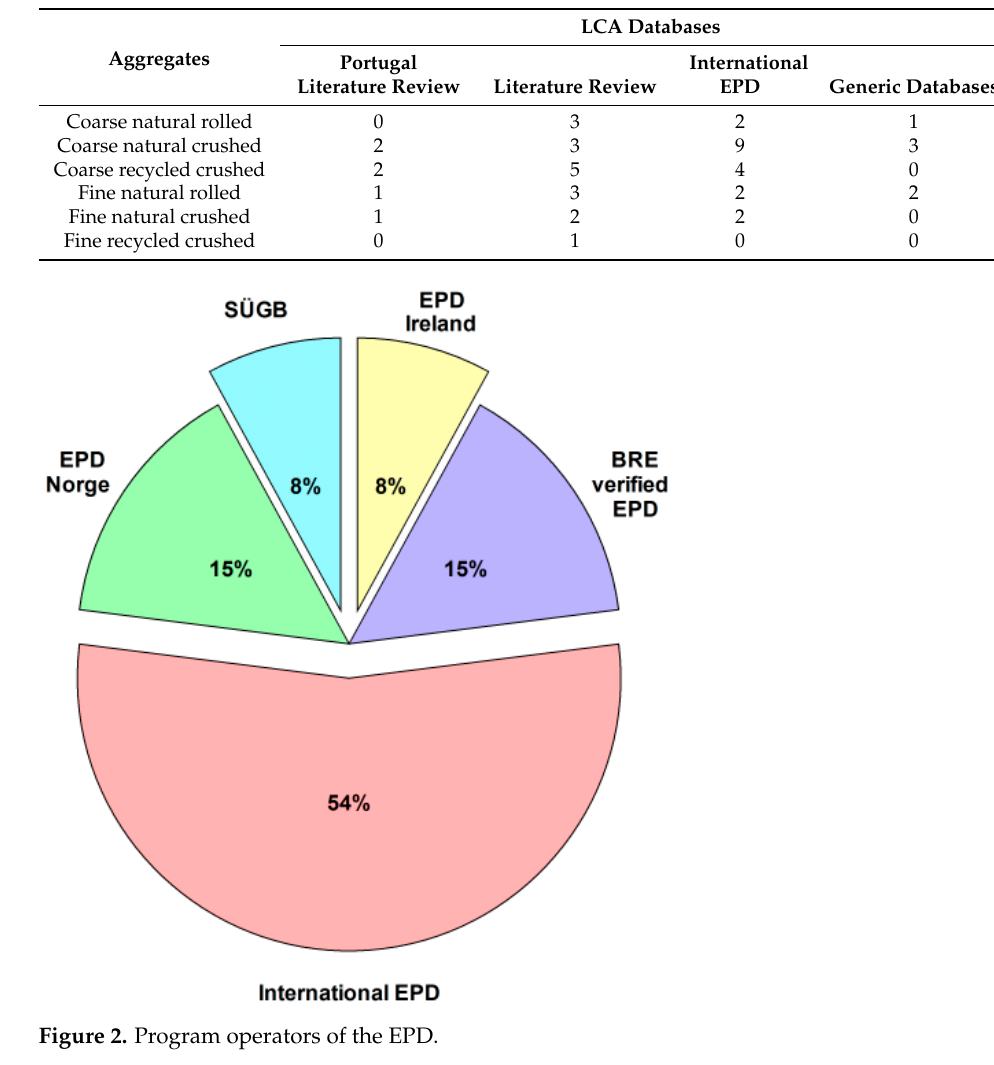
Table 3. Generic databases.